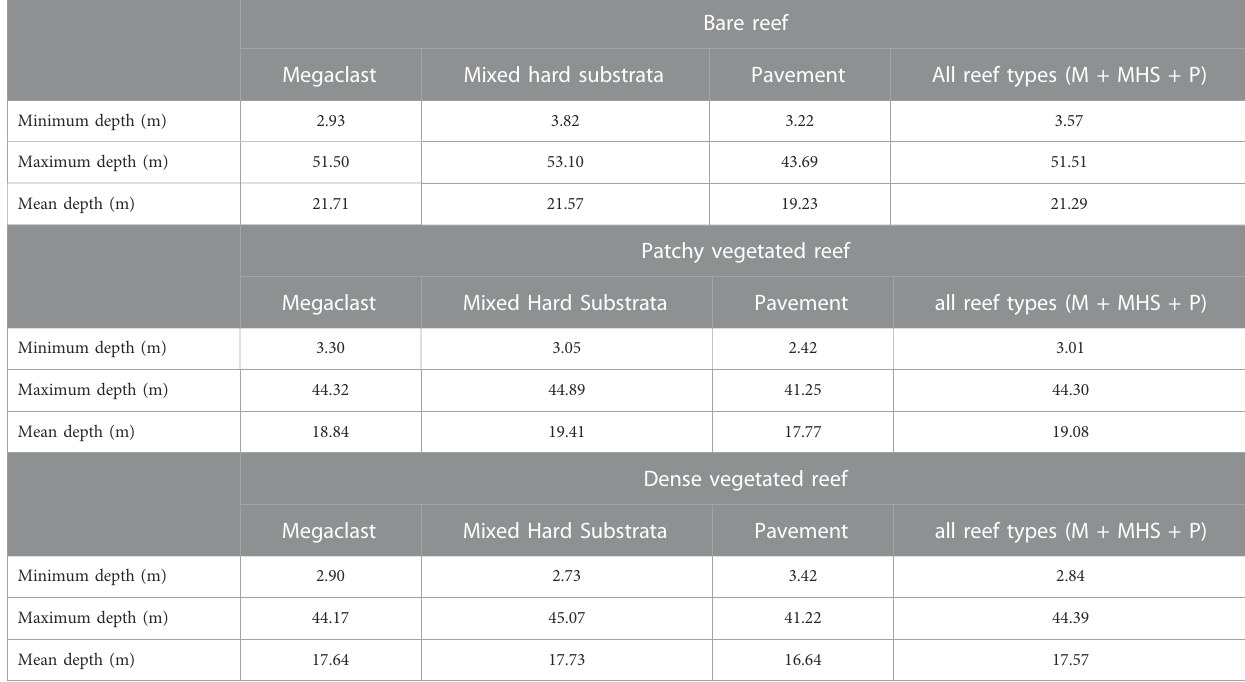
TABLE 4 Depth summaries of vegetation density likelihood classes by reef